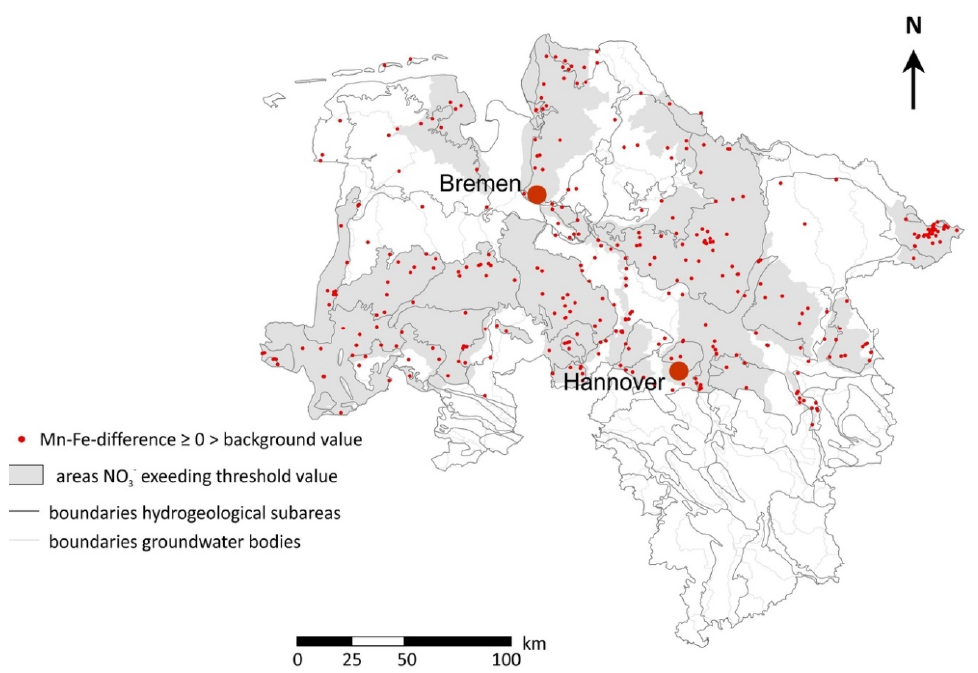
Figure 8. Areas with nitrate concentrations above the drinking water standard of 50 mg/L